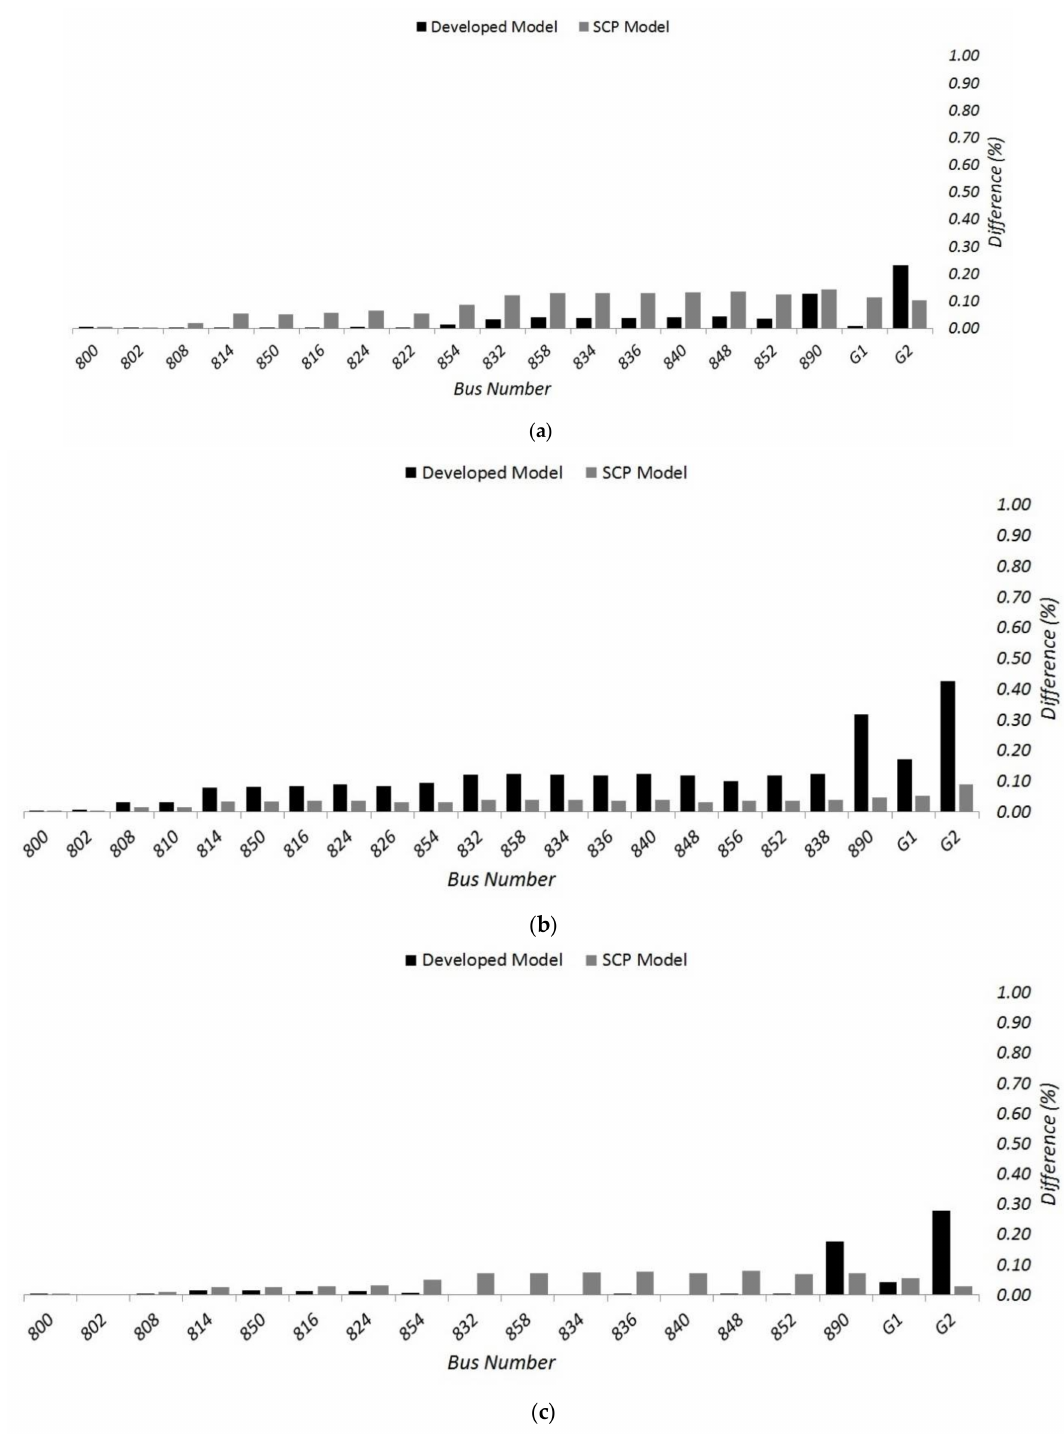
Figure 9. Phase voltage differences (%) of each bus with models for ( a ) Phase A; ( b ) Phase B; and ( c ) Phase